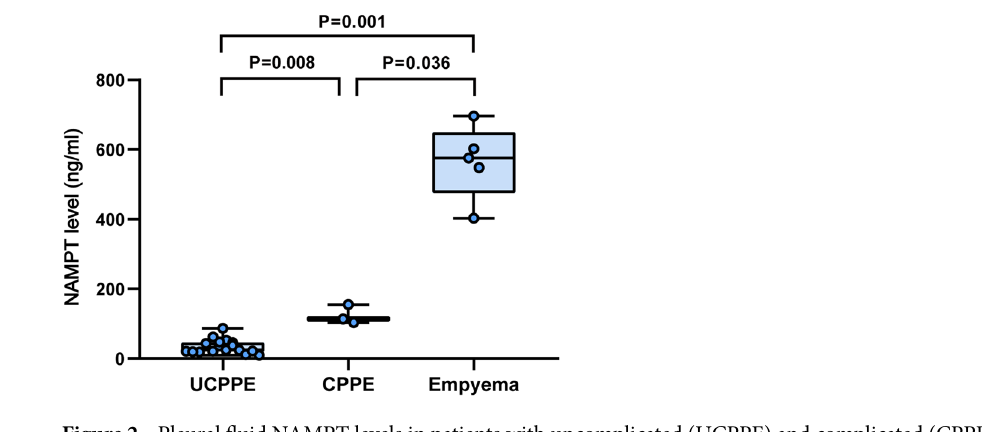
Figure 2. Pleural fluid NAMPT levels in patients with uncomplicated (UCPPE) and complicated (CPPE) parapneumonic pleural effusion and